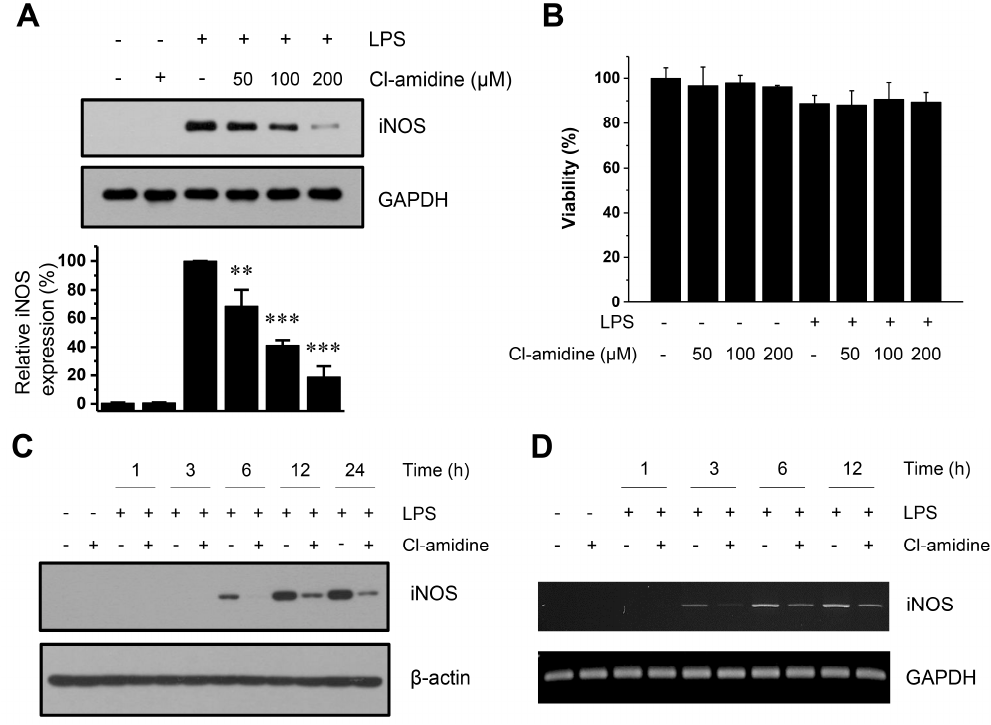
Figure 3. Cl-amidine suppresses iNOS induction in LPS-treated DCs. LPS (0.1 µ g/mL)-treated or -untreated DCs (5 × 10 6 cells) were cultured in the absence or presence of Cl-amidine (50, 100, or 200 µ M) for 24 h. ( A ) iNOS expression was detected by Western blotting with an anti-iNOS antibody. Anti-glyceraldehyde 3-phosphate dehydrogenase (GAPDH) was used as the loading control. Bottom panel: relative intensity of iNOS in upper panels with loading controls using three individuals of each group. Error bars represent SD. ** p < 0.05, *** p < 0.001. ( B ) Cell viability was measured using a CCK-8 staining. ( C ) In the absence or presence of Cl-amidine (200 µ M), DCs (4 × 10 6 cells) were incubated with LPS (0.1 µ g/mL) for the indicated lengths of time. iNOS expression was detected by Western blotting with an anti-iNOS antibody. β -actin was used as the loading control. ( D ) In the absence or presence of Cl-amidine (200 µ M), DCs (5 × 10 6 cells) were incubated with LPS (0.1 µ g/mL) for the indicated lengths of time. mRNA levels of iNOS and GAPDH were analyzed by RT-PCR.